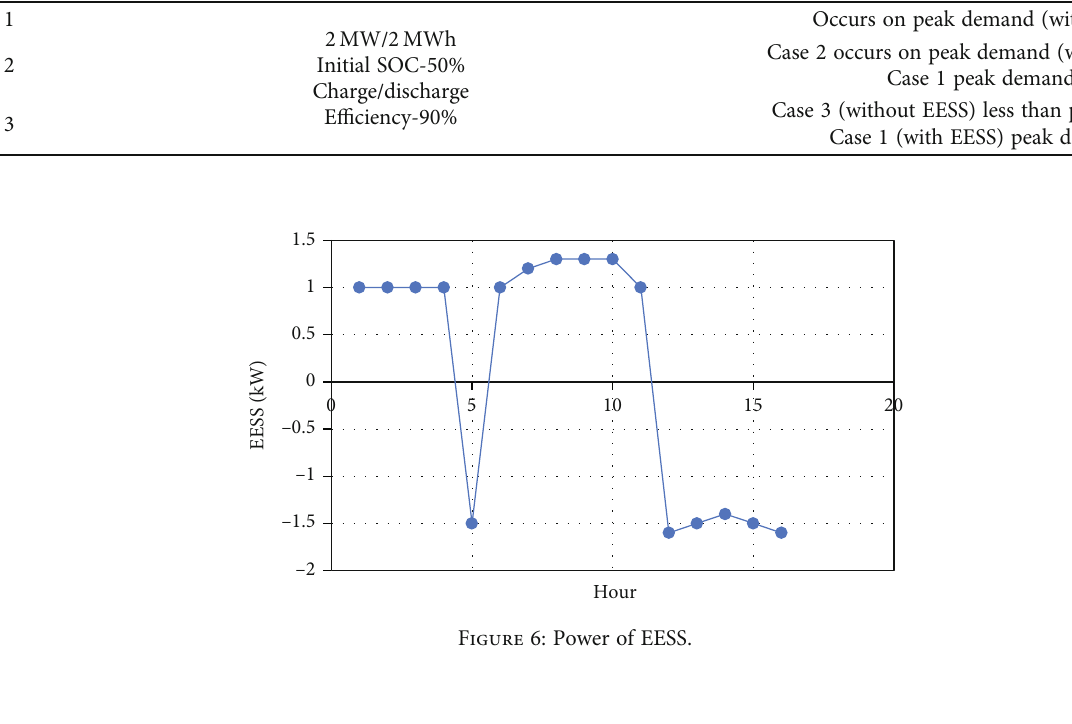
Table 4: Case summary of case 1.